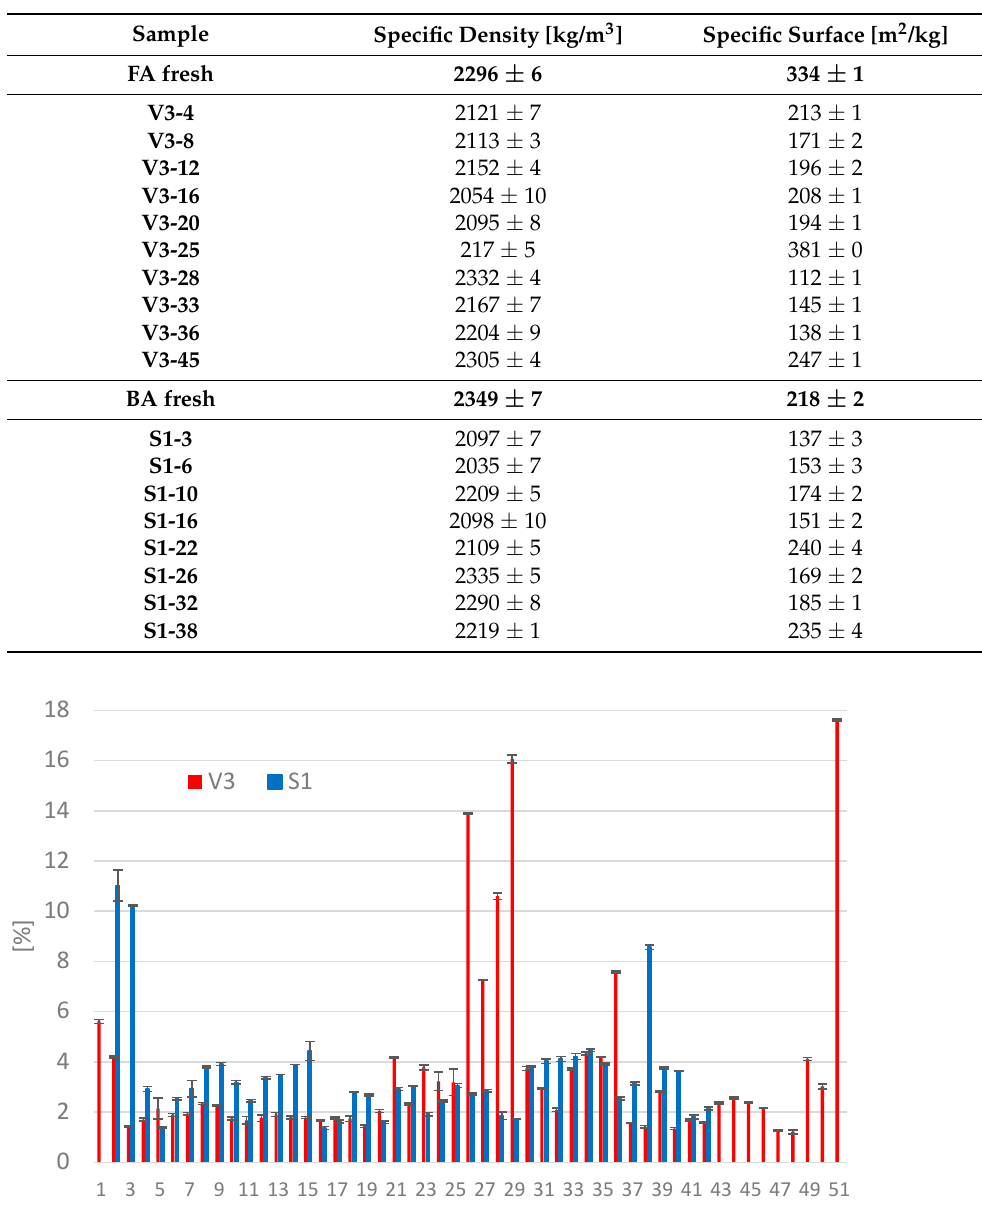
Table 1. Values of Specific Density and Specific Surface for Selected Samples from Core Boreholes V3 and S1 and for Fresh Fly Ash (FA) and Fresh Bottom Ash (BA).